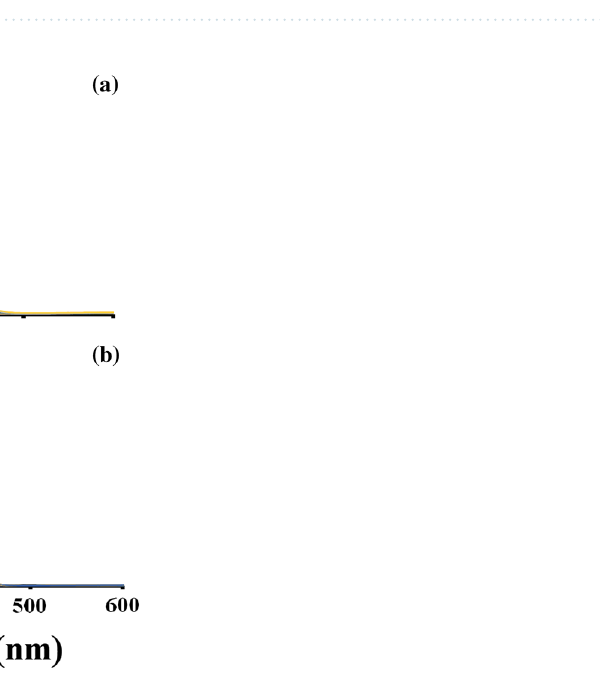
Figure 2. Changes in UV–vis absorption of 1–6 (5 × 10 −5 M) upon addition of 30 equiv. of different tetra- butylammonium salts of anions in CH 3 CN solution as shown in ( a–f )